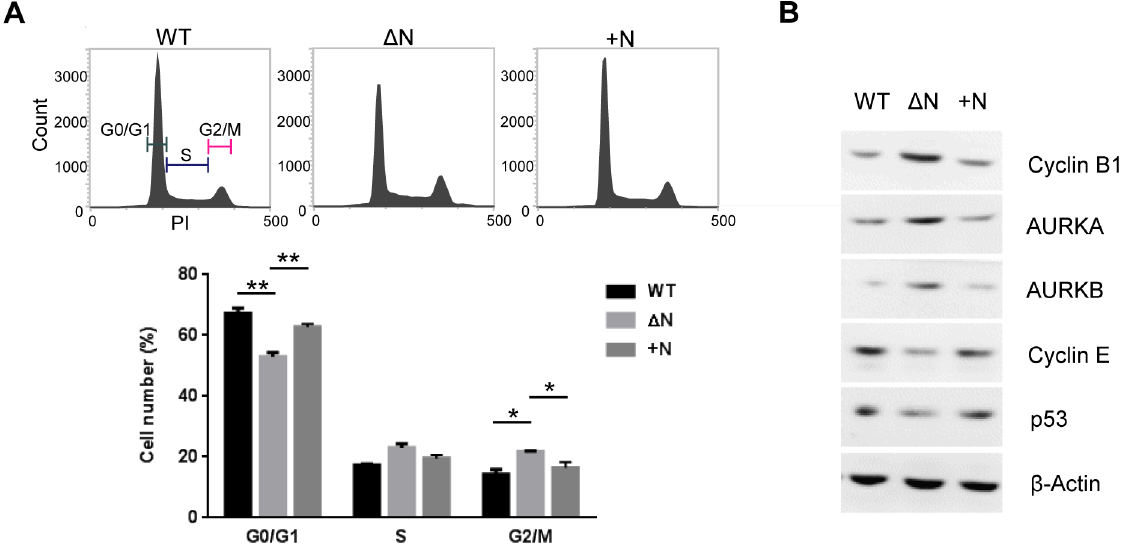
Figure 6. NLS insertion into hARD1 rescues the impaired cell cycle. A . Insertion of NLS rescued hARD1 D N-expressing HeLa cells from G2/M arrest. Cell cycle profiles of stable HeLa cells were determined by flow cytometry analysis. Upper, representative cell cycle profiles; lower, the percentage of cells in each phase. B . The exogenous NLS restored the altered protein expression involved in cell cycle regulation of the NLS mutant. The levels of Cyclin B1/E, AURKA/B, and p53 were determined in cell extracts from hARD1 WT-, D N-, and + N-expressing cells by western blot.